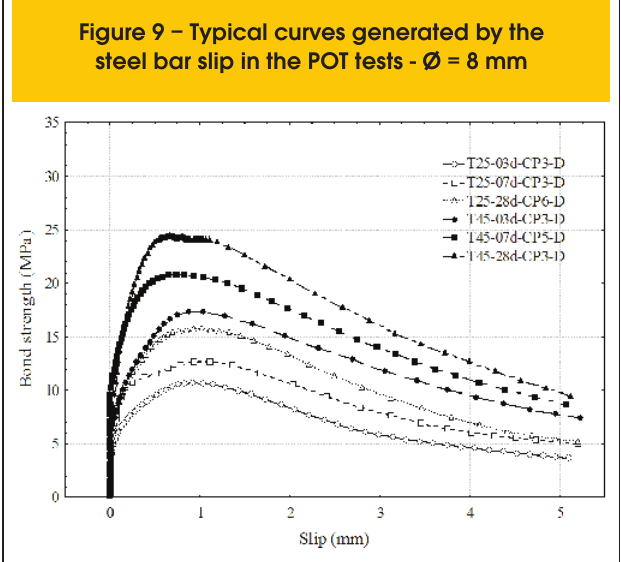
Figure 9 – Typical curves generated by the steel bar slip in the POT tests - Ø = 8